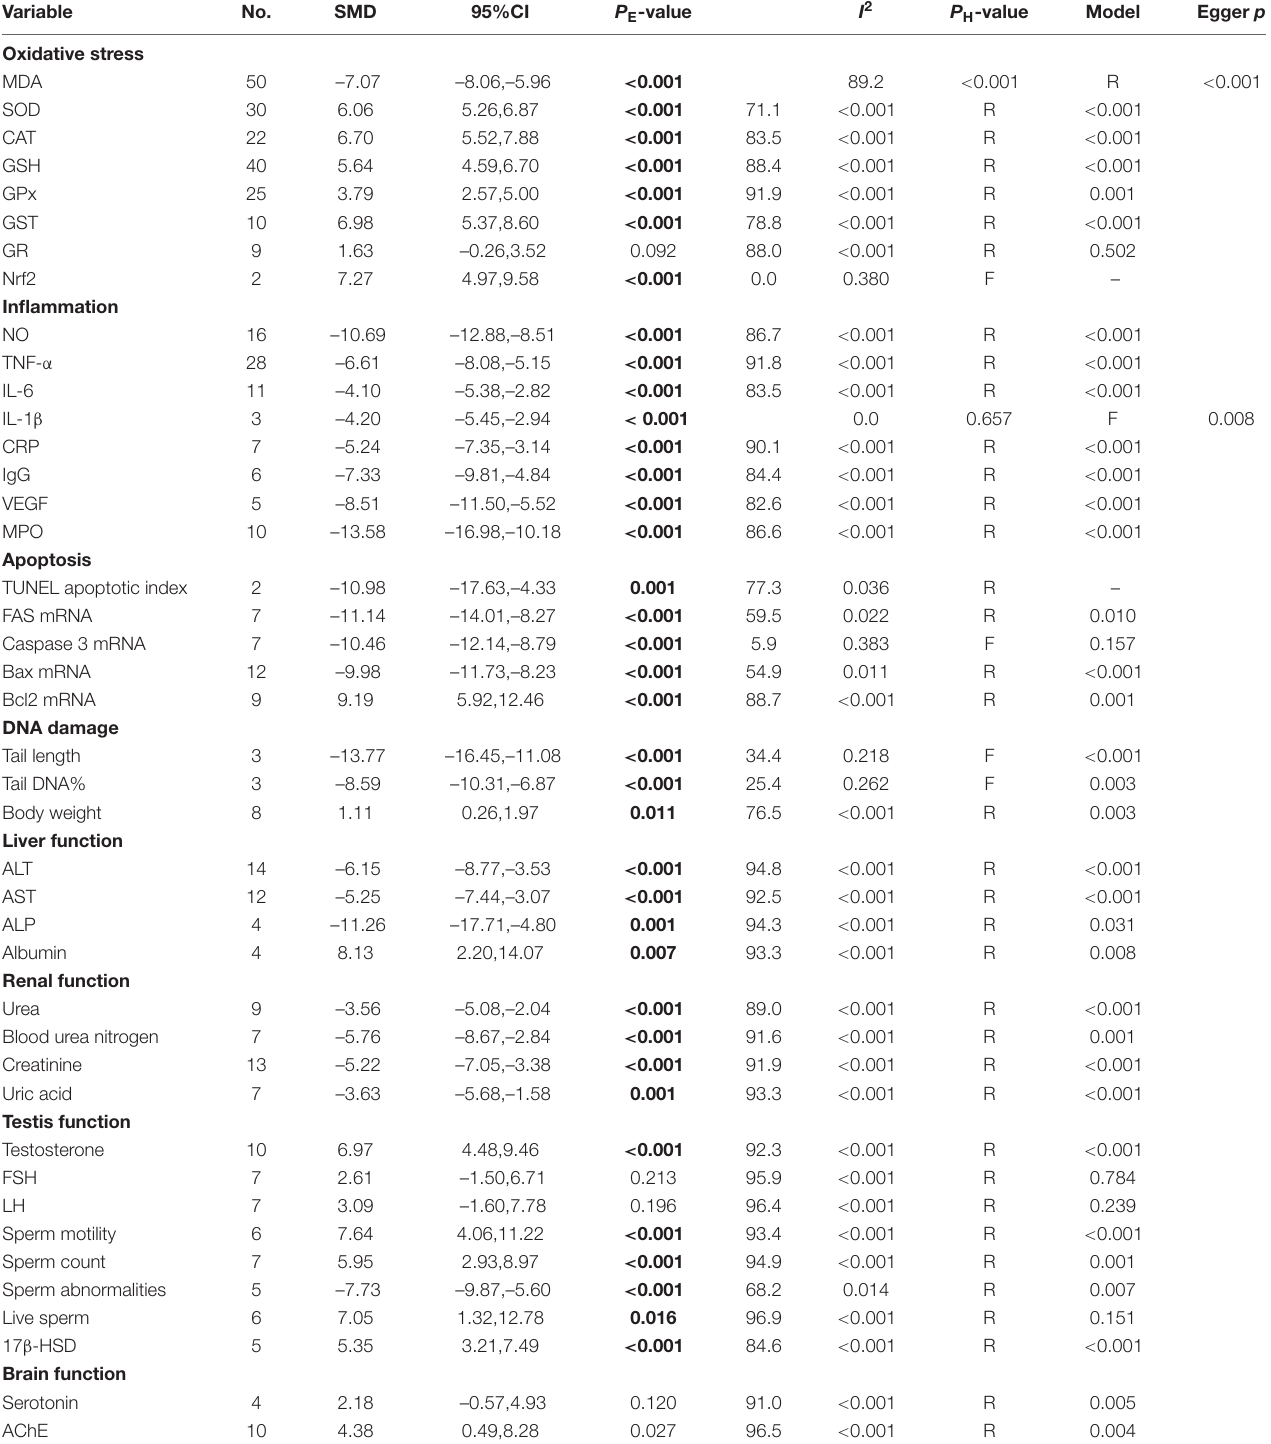
TABLE 3 | Meta-analysis